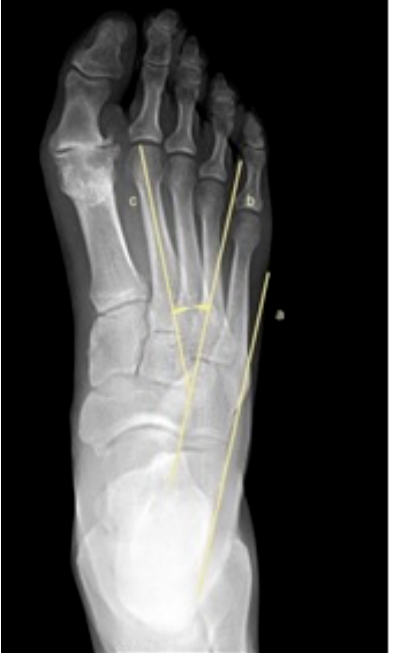
Figure 2. Dorsoplantar weightbearing radiograph of modified Sgarlato’s angle. The Rearfoot angle [30,33], Figure 3, is the angle between a parallel line to the lateral border of the calcaneum and second metatarsal axis. Line (a) is parallel to the lateral border of the calcaneum, line (b) is parallel to line (a), line (c) axis 2nd metatarsus. The Rearfoot angle is between line (b) and line (c).